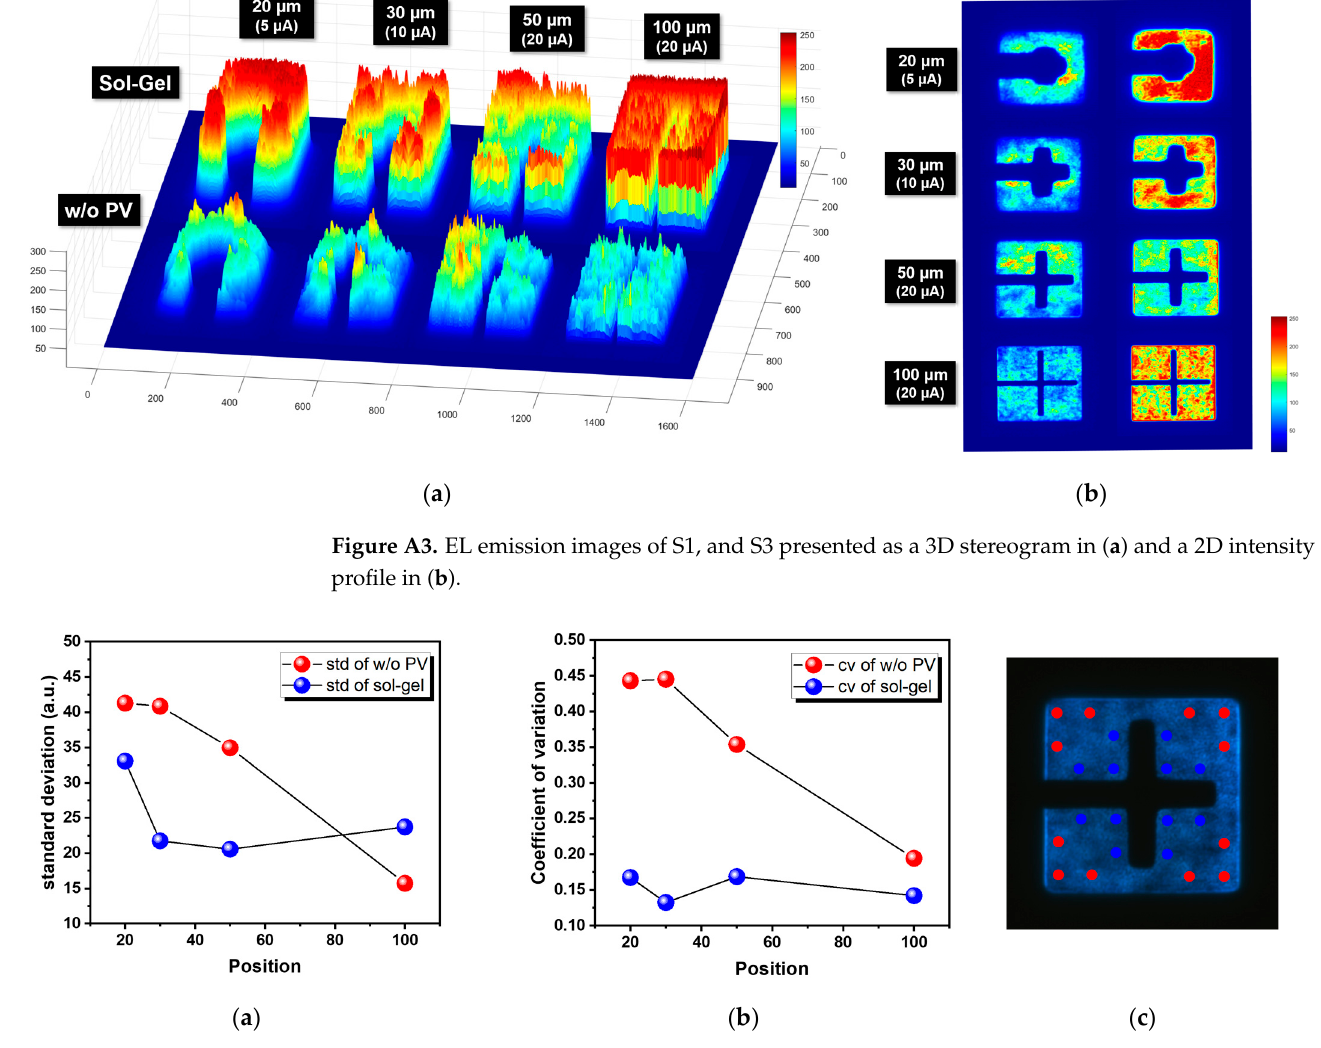
Figure A4. ( a ) Standard deviation and ( b ) coefficient of variation of Micro-LEDs with different passivation and sizes, ( c ) presents the results of our point selection method, which divides the edge (red) and center (blue) regions .